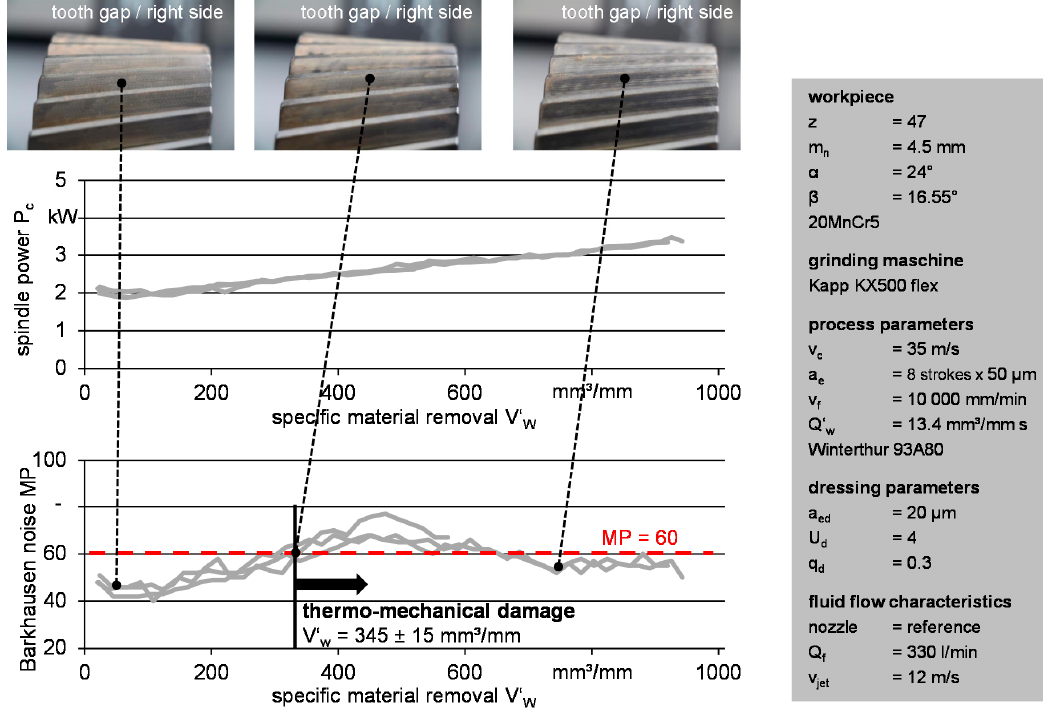
Figure 9. Barkhausen noise and spindle power for the reference gear grinding process.